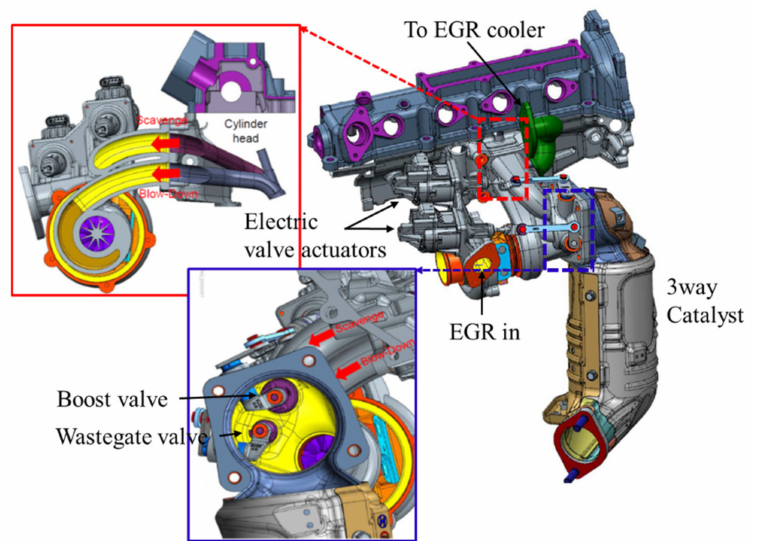
Figure 9. Turbocharger assembly